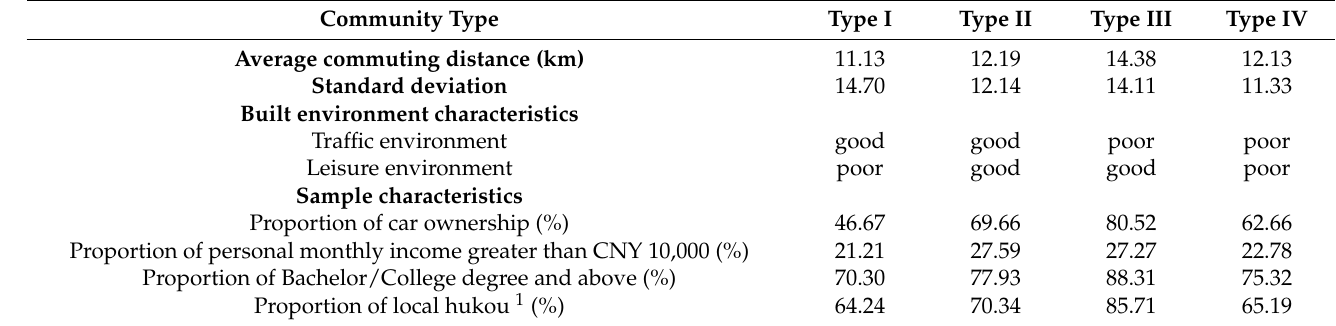
Table 1. Sample characteristics and built environment characteristics of different types of